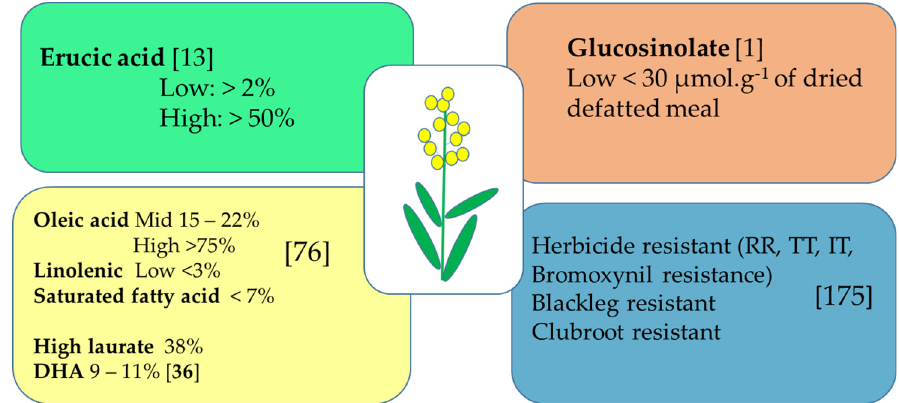
Figure 1. Desired optimal traits in current canola varieties, specifically for oil and meal content, herbicide, and disease resistance.